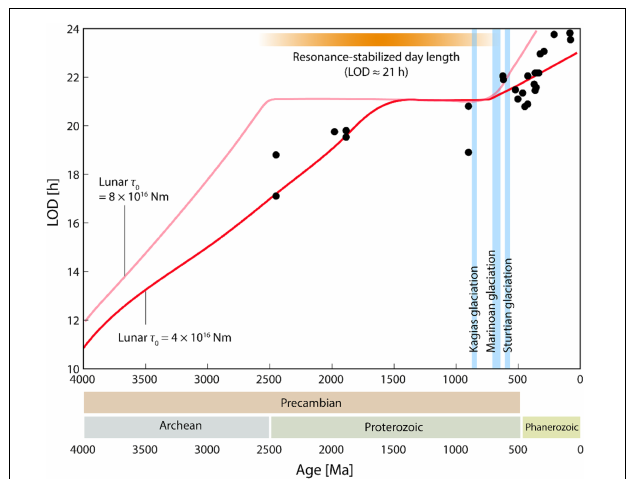
FIGURE 3 | Changes of LOD over a period of 4000 million years (Ma). Black dots represent empirically determined LOD values based given by Williams. The two red functions represent different predictions of the long-term LOD changes by Bartlett and Stevenson based on varying choices of τ 0 , the lunar torque. Only the prediction based on the upper and lower range of τ 0 values used for the simulation are shown for clarity.